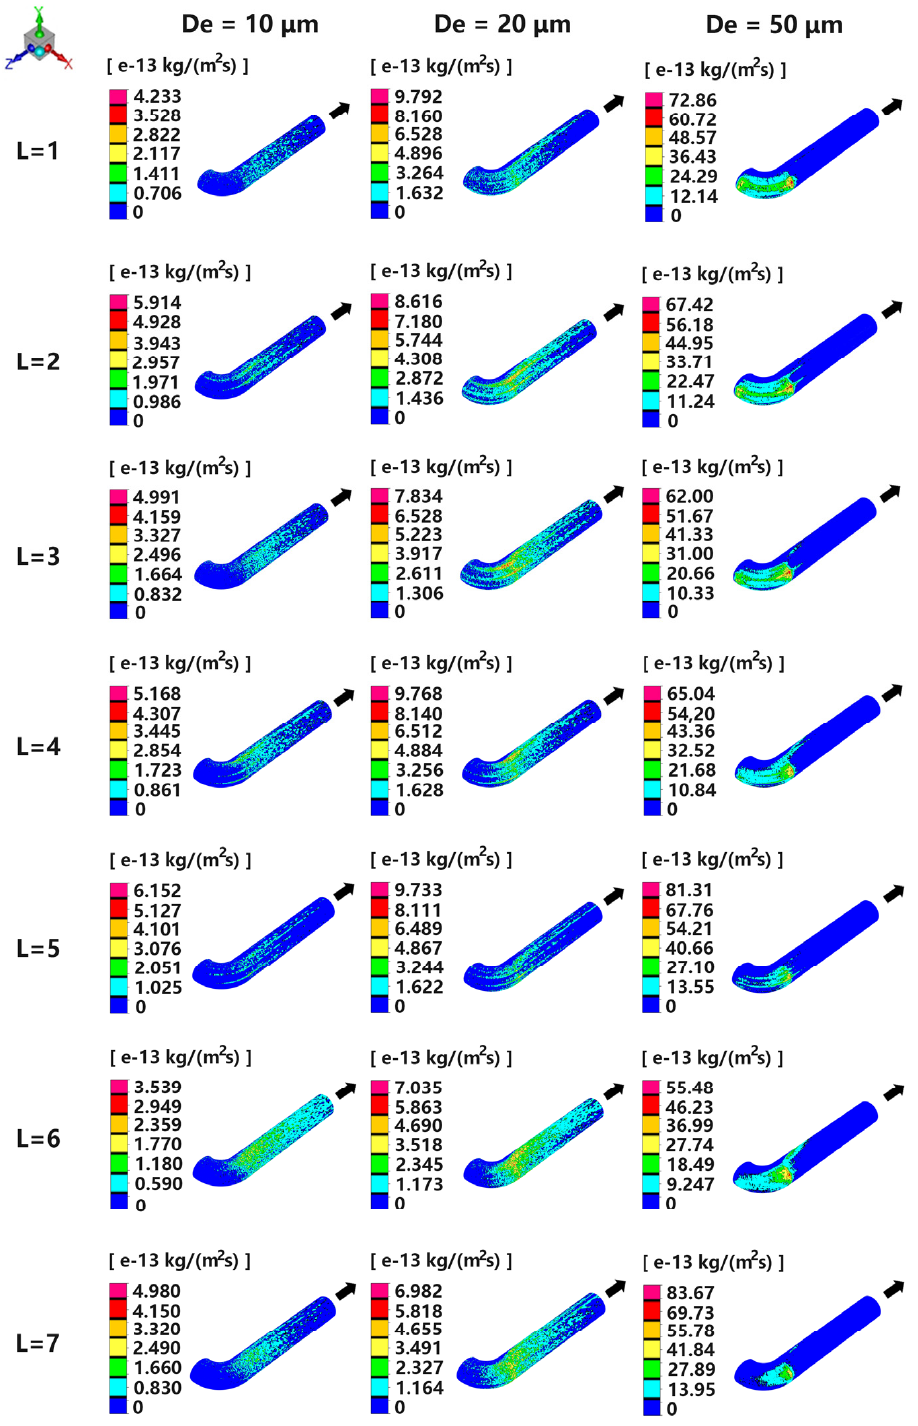
Figure 14. The erosion contours at Elbow-2 and Straight-3 with the different Straight-2 lengths and different average diameters.